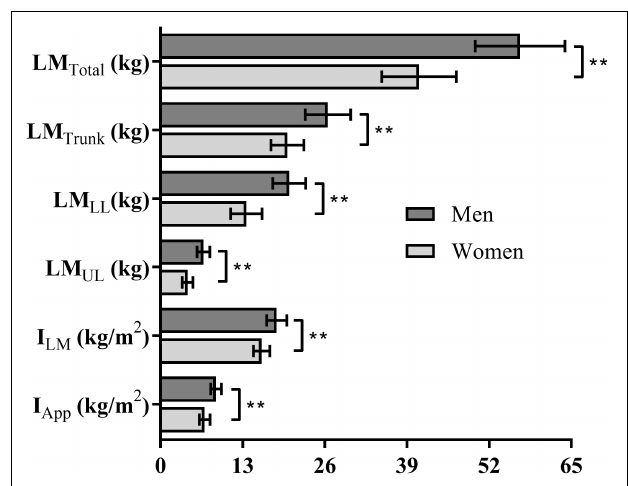
FIGURE 2 | Body composition variables for men and women. Obs.: Significantly different at ρ ≤ 0.01**.